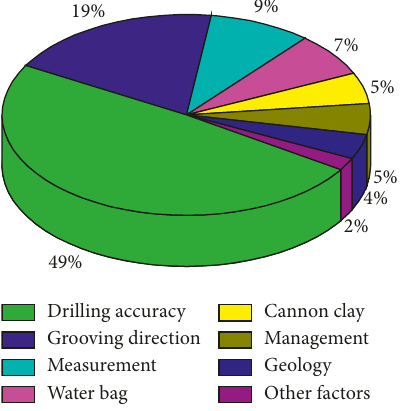
Figure 20: Proportion of influencing factors of ECHBT